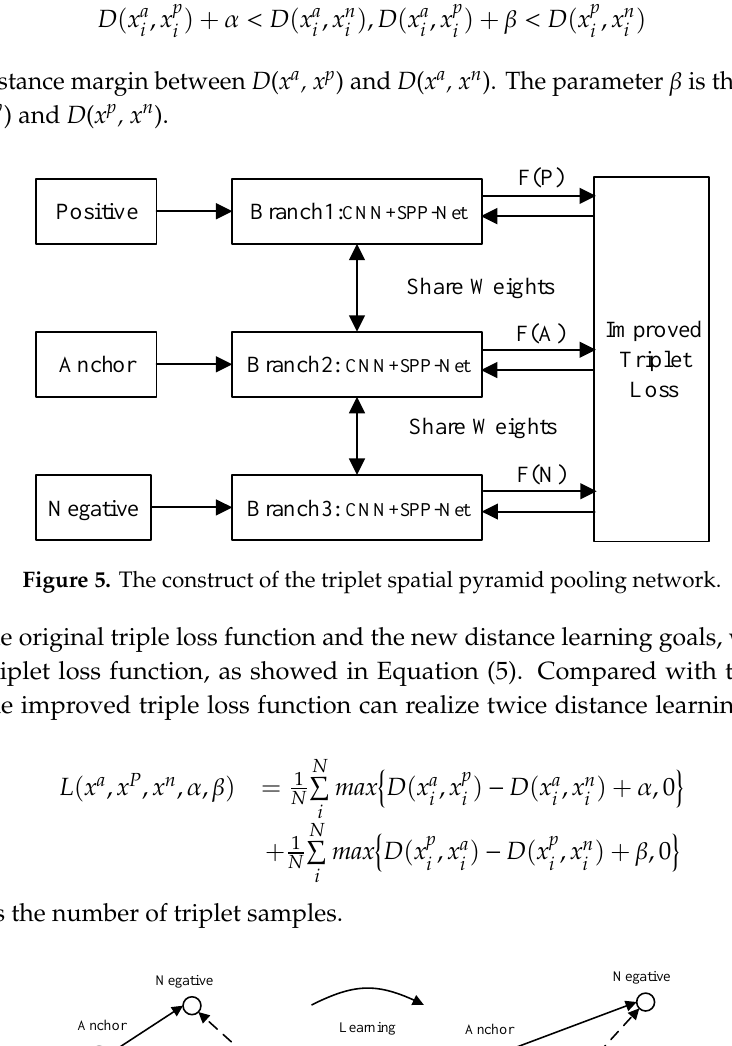
Figure 5. The construct of the triplet spatial pyramid pooling network.